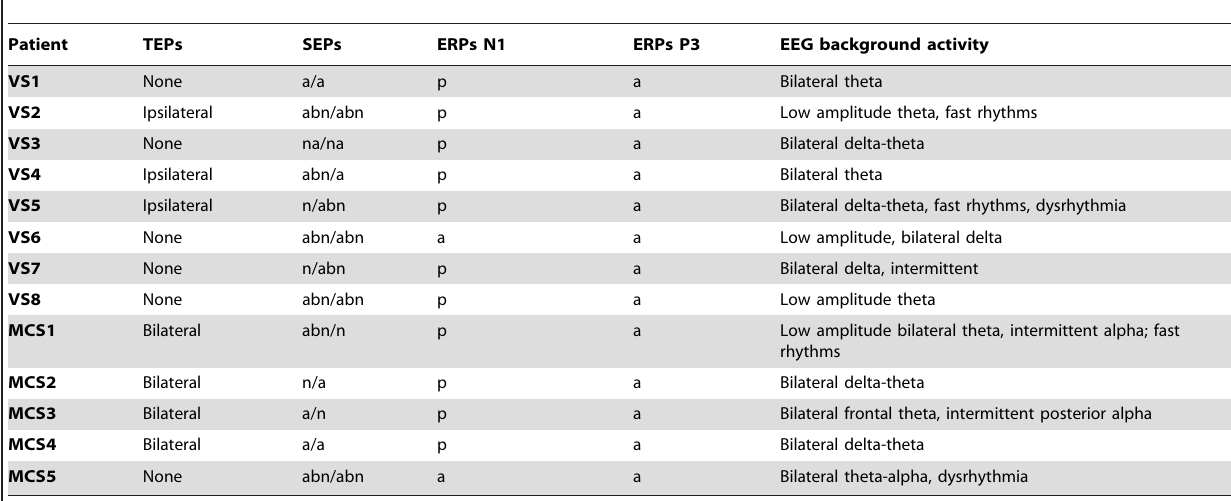
Table 3. Summary of neurophysiological